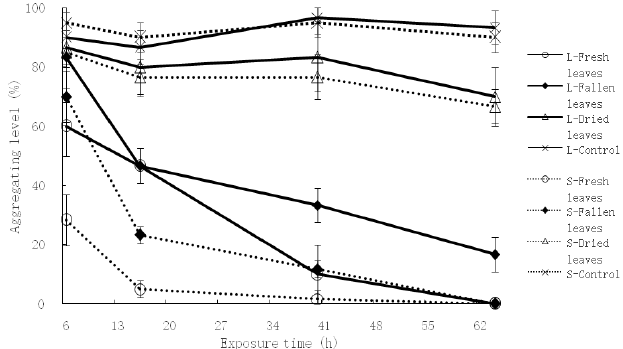
Fig 2 . Effects on Aggregation Level of workers (L: large workers, S: Small workers) after treated with different mashed leaves of M. alba ( Duncan′S Multiple-Range test,